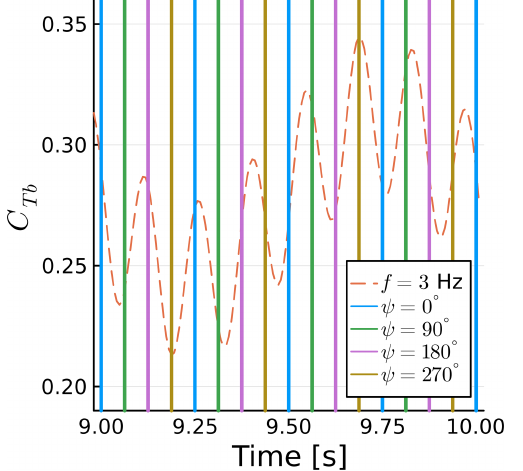
Figure 21. Time history of blade 1 thrust coefficient for a yaw case. Vertical lines show blade